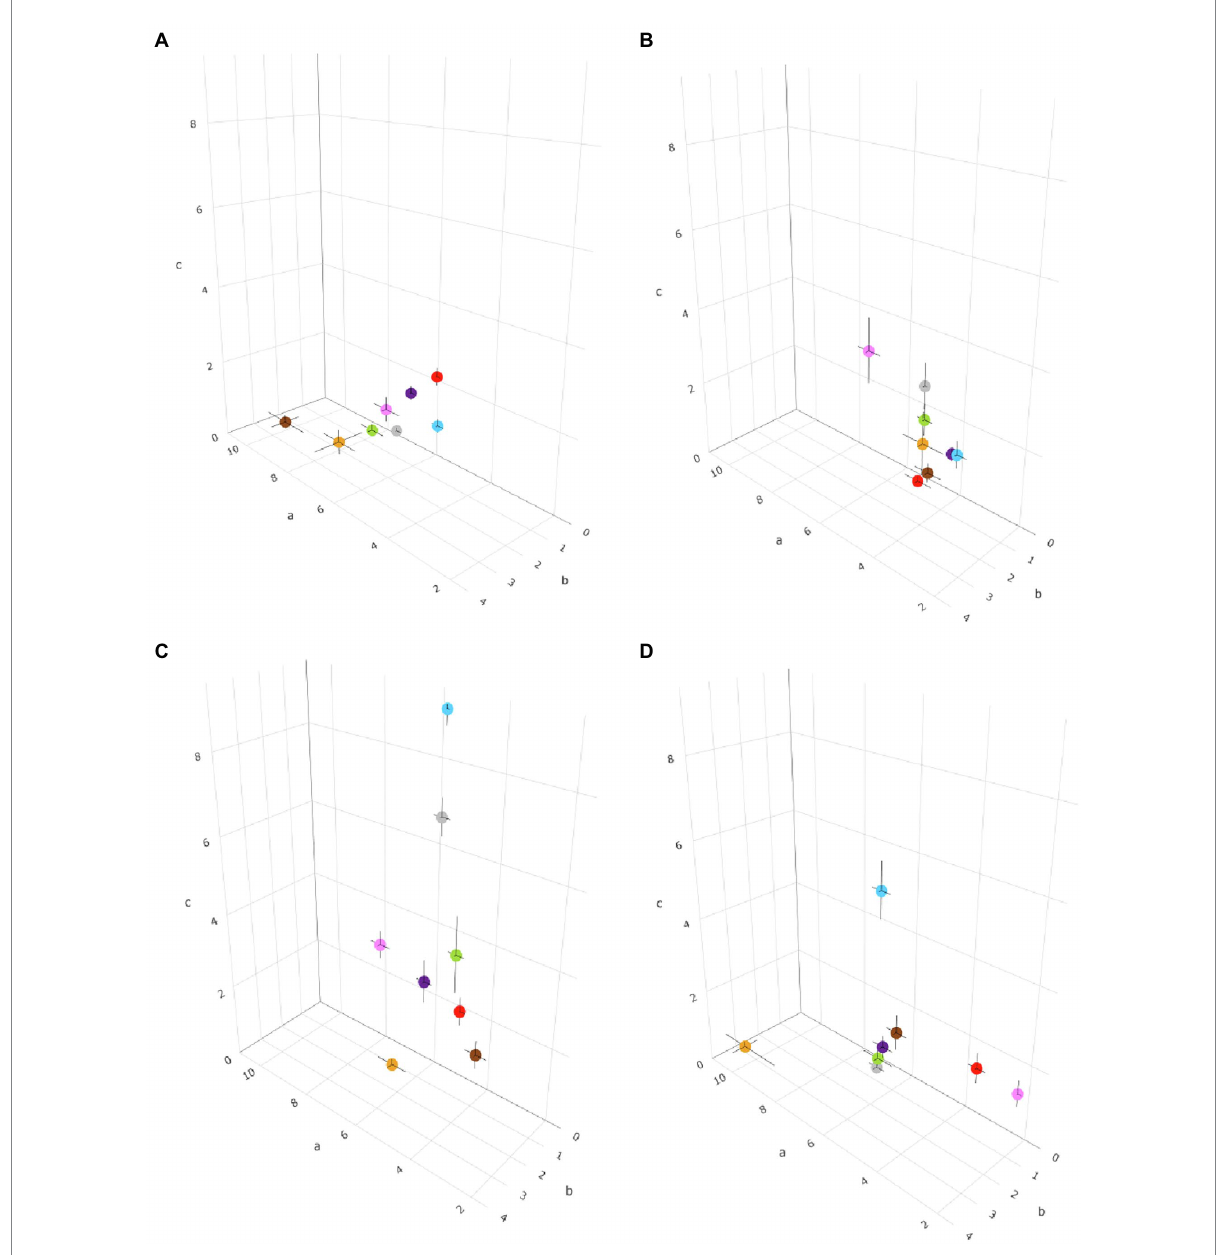
FIGURE 3 Three-dimensional distribution of eight Colletotrichum clades based on the temperature requirements of the pathogens, described by a , b , and c parameters in Equation (1) for (A) mycelial growth, (B) conidial germination, (C) sporulation, and (D) conidial infection. The parameter a is plotted on the x -axis, b is plotted on the y -axis, and c is plotted on the z -axis. Black bars represent the standard error of estimates of equation parameters in the three dimensions. Clades are indicated by different colors: red is acutatum, orange is graminicola, pink is destructivum, brown is coccodes, blue is dematium, purple is gloeosporioides, gray is truncatum, and green is